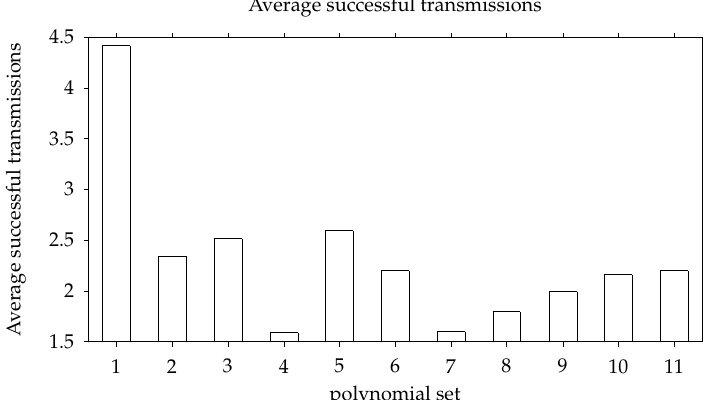
Figure 7. Average number of successful transmissions per frame per node corresponding to various polynomial sets. In all cases, the number of successful transmissions is between the expected maximum (i.e., 5) and minimum (i.e., 1)